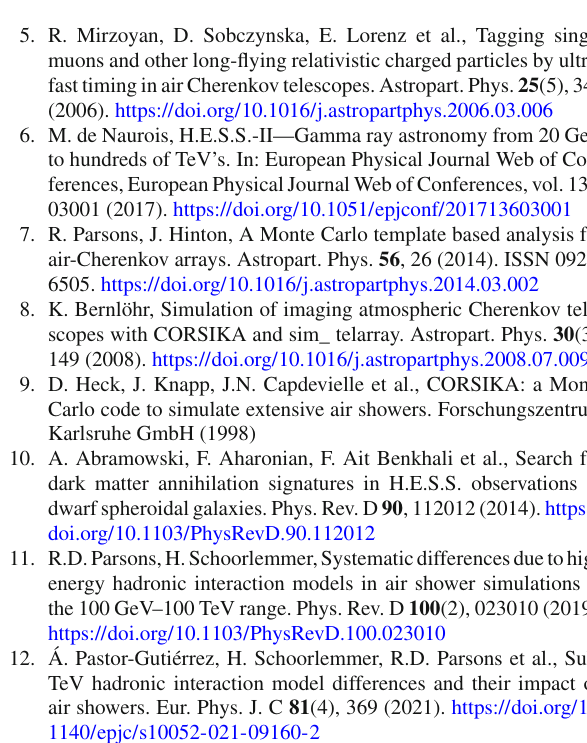
Fig. 7 Cut efficiencies of the hybrid reconstruction using the standard-hybrid cuts